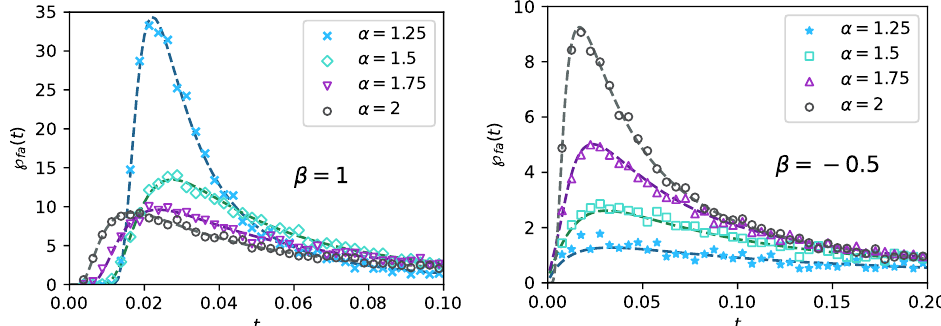
Figure 5. Short-time asymptotic of the first-arrival density of Lévy flights for different stable index α with K α = 10 and x 0 = 1. Symbols show the simulation results based on the Langevin approach and the dashed lines are computed from the exact analytical expression (20). We chose ∆ t = 0.0001 for N = 2 × 10 6 realisations, and the target size is 2 ( D α ∆ t ) 1/ α